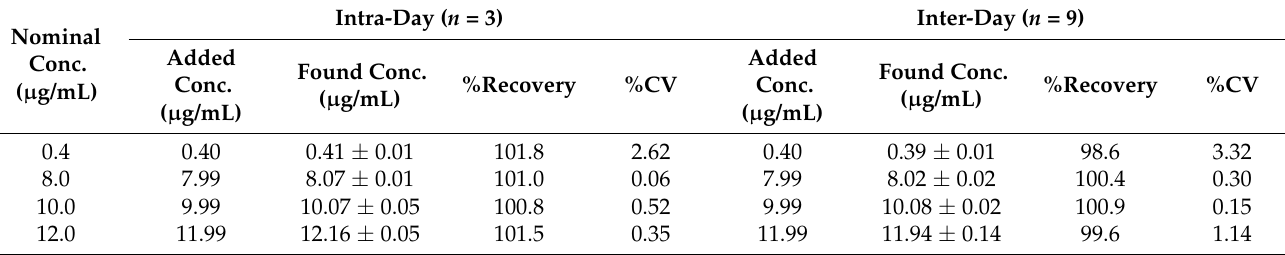
Table 4. The accuracy and precision of the